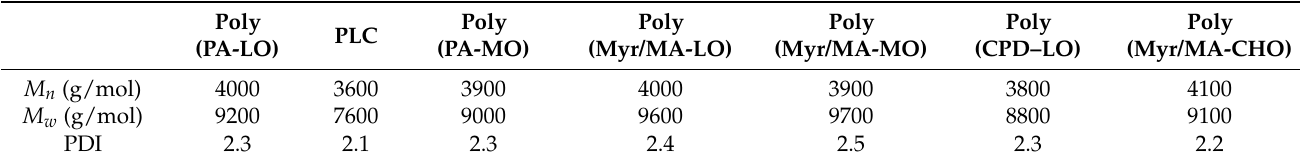
Table 2. GPC data of the selected terpene